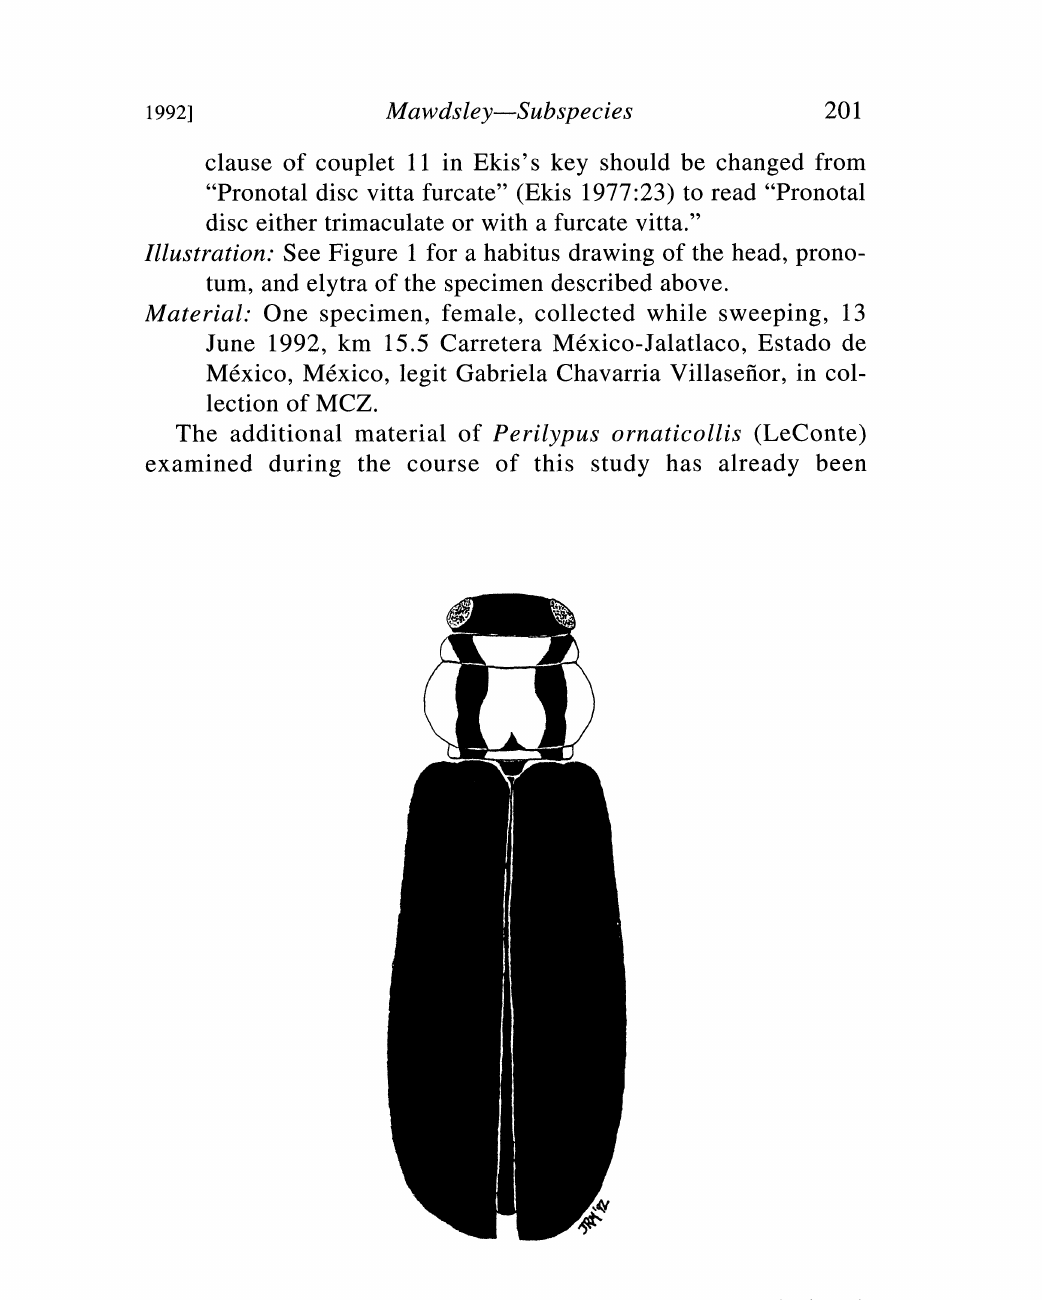
Figure 1: Perilypus ornaticollis (LeConte), trimaculate phenon. Length of speci- men shown 10.1